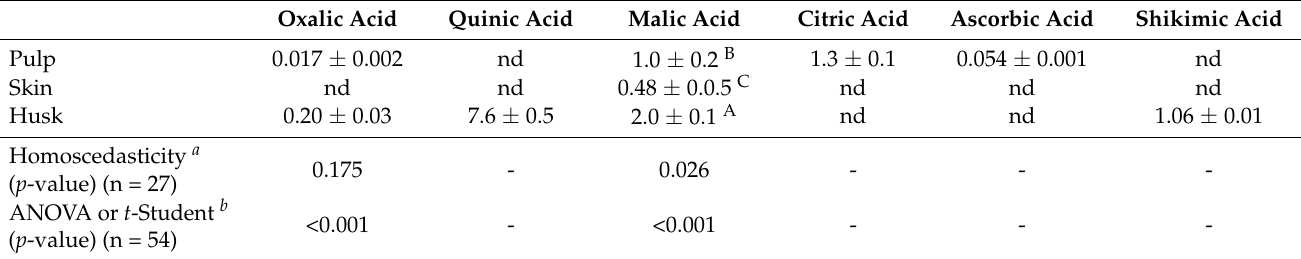
Table 1. Organic acid profile (g/100 g dw) of pulp, skin, and husk of Aesculus hippocastanum L. fruits (mean ±